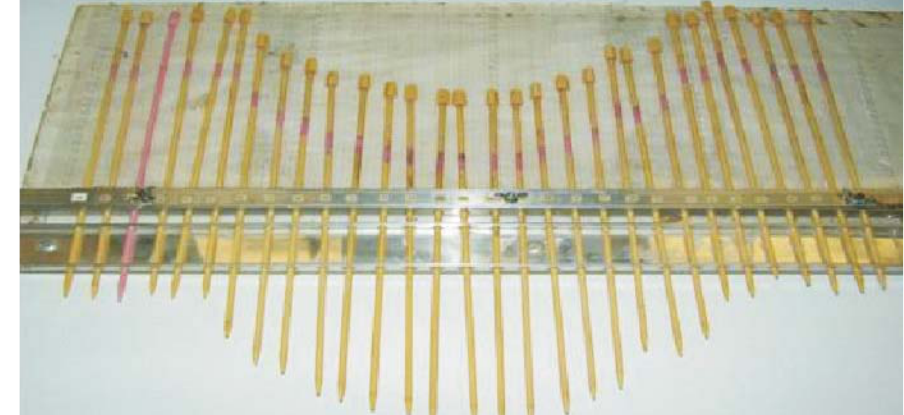
Figura 1. Perfilômetro utilizado para obtenção das seções geométricas dos sulcos de erosão pré-formados em um Cambissolo Háplico do semiárido do Estado de